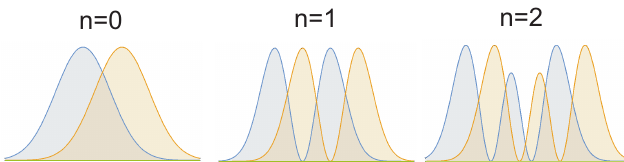
Figure 6. (left) Profiles of the densities of states given by Equation (10) for neighboring electrons with k and k + 1 for n = 0,1,2, where n is the Landau index enumerating the Hermite polynomial in Equation (10). For n odd the central peak disappears, which diminishes by factor ca. 4 the repulsion of two successive electrons (holes) in the k